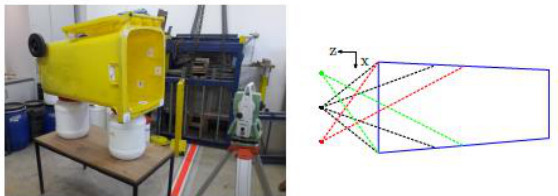
Figure 5: Measurement of the position of the coded targets with a total station for a 240 l waste bin (yello bin for package waste)